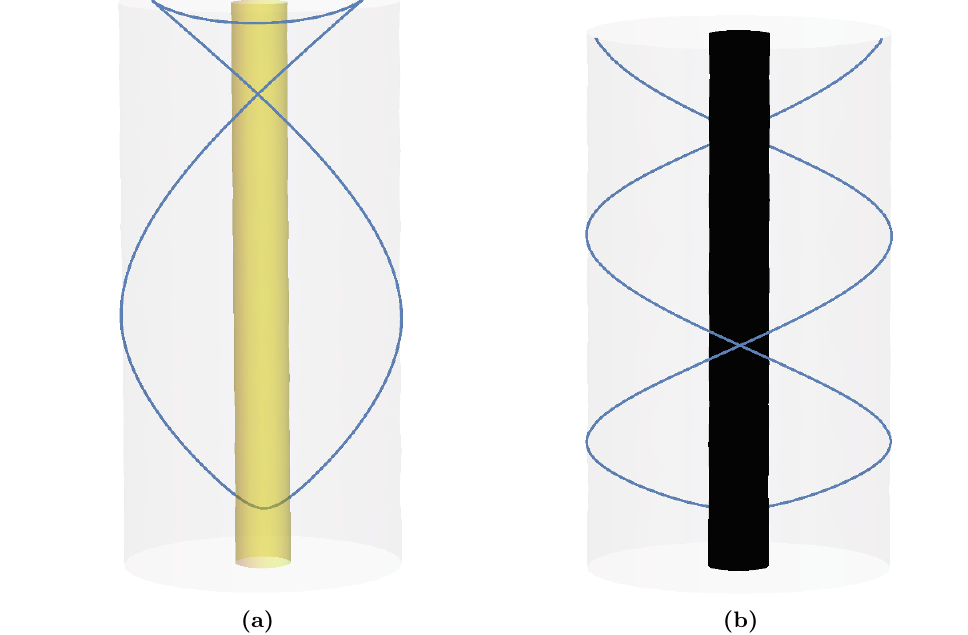
Figure 7. Intersection of the light-cone and @M for: (a) Self-gravitating radiation gas in AdS, and (b) AdS Eternal Black